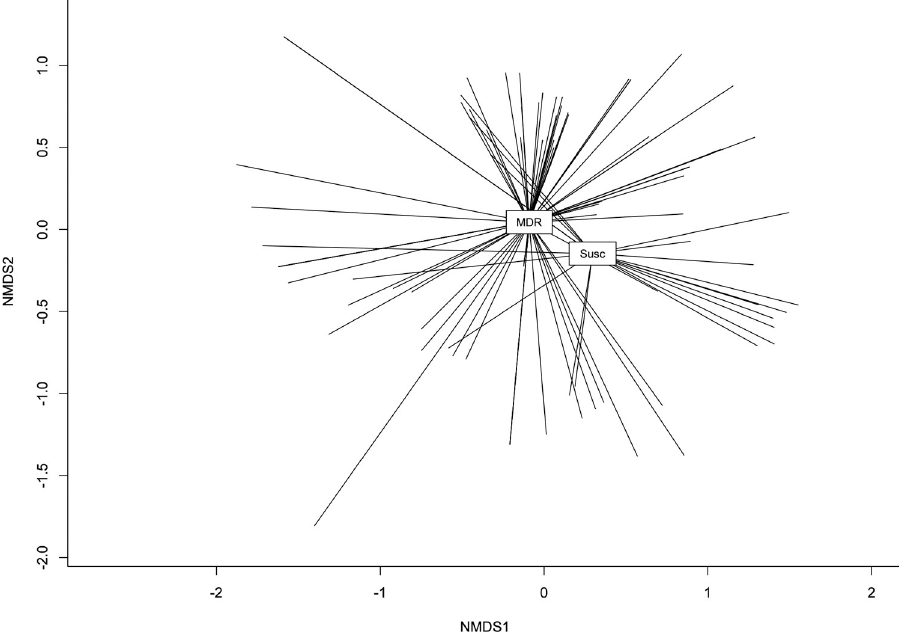
Fig 4. Nonmetric multidimensional scaling (NMDS) analysis of virulence gene presence/absence (Jaccard distance) with isolates grouped based on resistance gene presence (stress = 0.19) (ANOSIM R = 0.1689, P = 0.001).